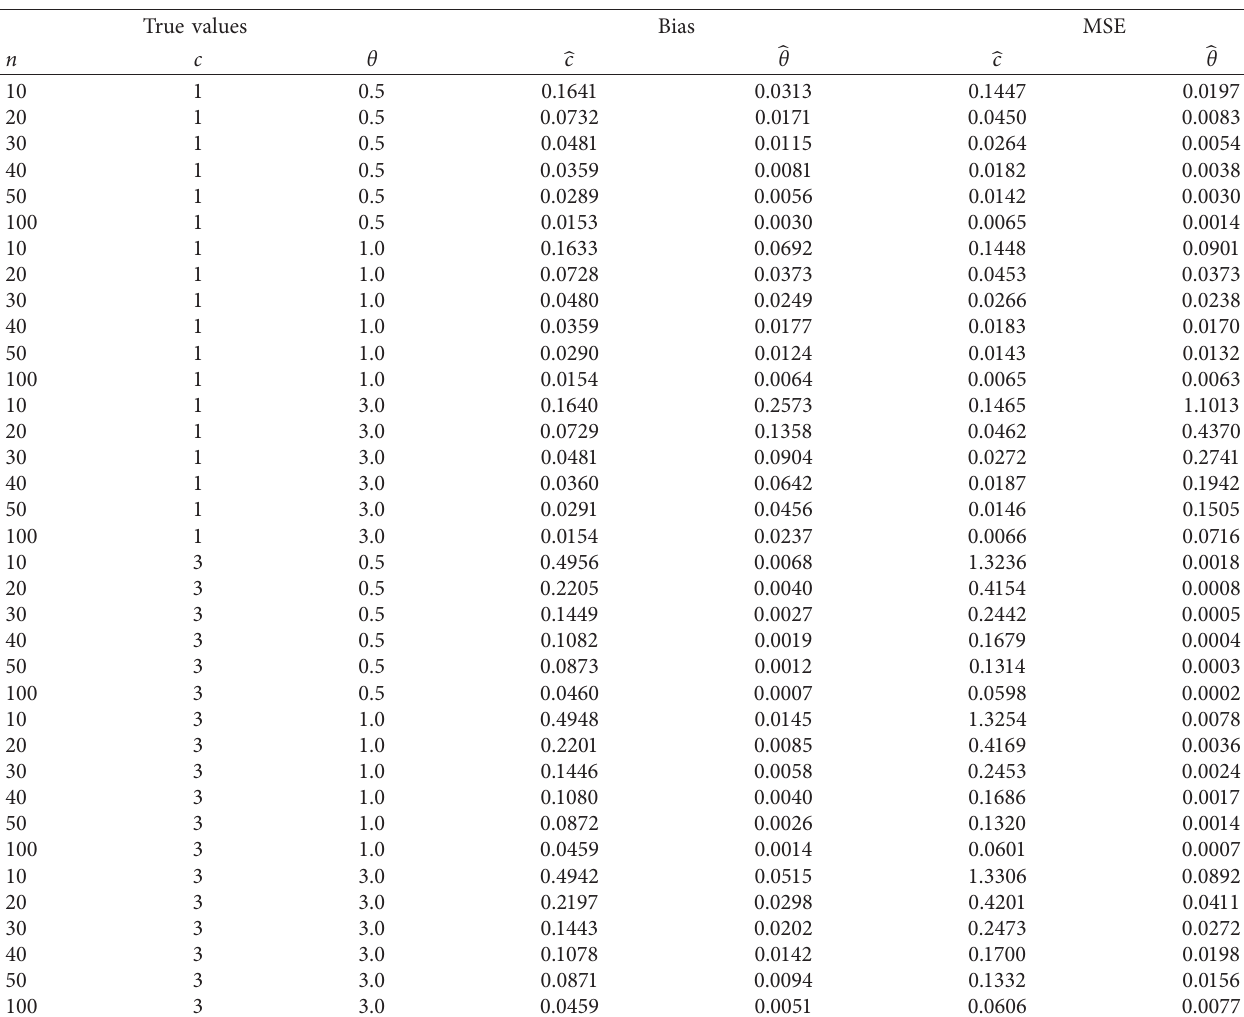
Table 2: Average biases and MSEs of the ML estimates of the parameters of GWL distribution. True values Bias MSE